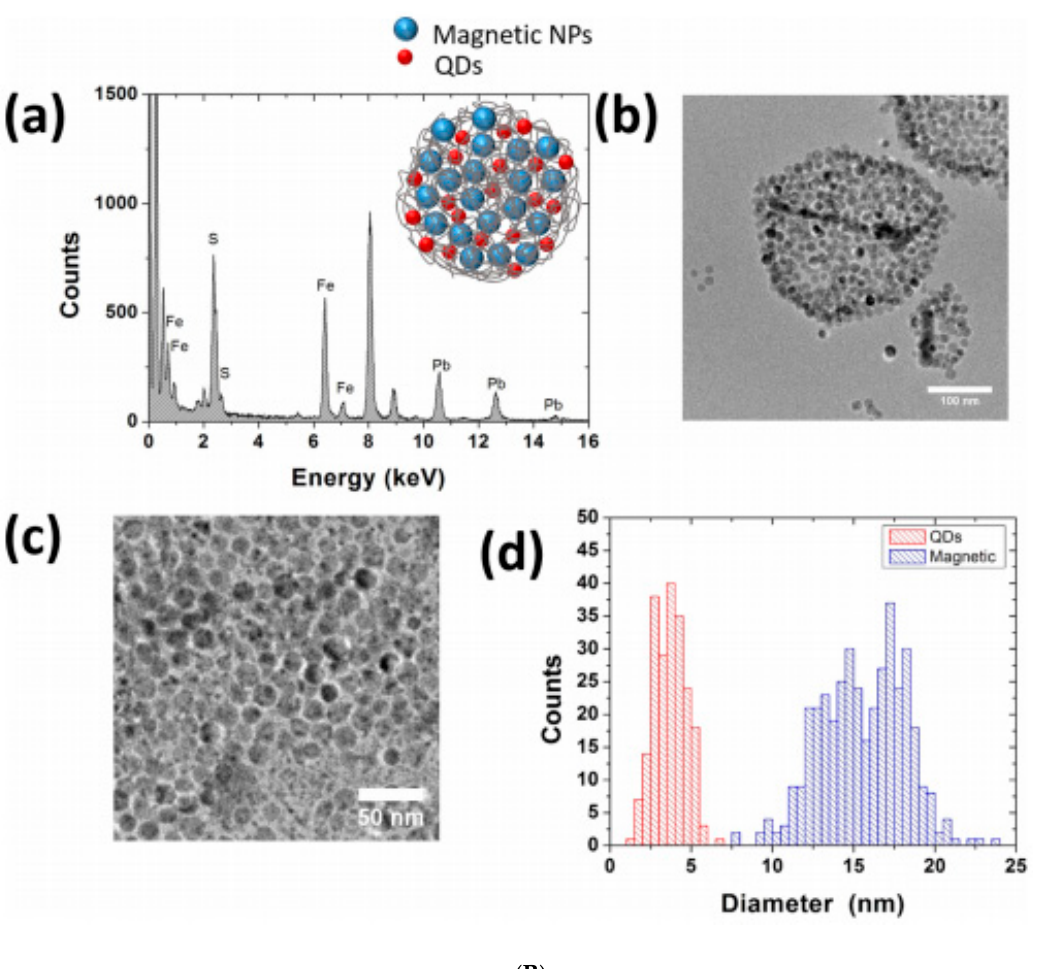
Figure 3. Co-assembling quantum dots and magnetic nanoparticles (NPs) of a ferrofluid in a magnetoresponsive core–shell nanostructure. ( A ) Synthesis and characterizations of core–shell-structured supraparticles (CS-SPs). ( a ) Schematic of the formation of the CS-SPs. A set of TEM images of CS-SPs at different magnifications. Scale bars, 500 nm, 100 nm, and 10 nm ( b – d ). Ferrofluid: magnetite NPs in chloroform carrier. Characteristic sizes: 9.0 nm for QDs (CdSe-CdS) and 5.9 nm for magnetite NPs (reprinted by permission from Copyright Clearance Center: Springer Nature, Nature Communications,[144], Copyright 2014); ( B ) ( a ) Compositional analysis (EDX) of a PLGA nanostructure denoting the presence of elements of both magnetic IONPs and QDs (PbS). (inset) Schematic diagram of the magnetic NPs and QDs in the PLGA nanostructure. ( b ) TEM image of a typical PLGA nanostructure. ( c ) A detailed TEM image of a PLGA nanostructure revealing the presence of two types of NPs inside the structure. ( d ) Size distribution of both types of particles obtained from TEM images. The size distribution corresponds to the sizes of the magnetic NPs (15 nm) and QDs (4 nm). Ferrofluid: oleic acid ‐ coated magnetite NPs in hexane carrier. (reprinted with permission from [145]. Copyright 2016 American Chemical Society).